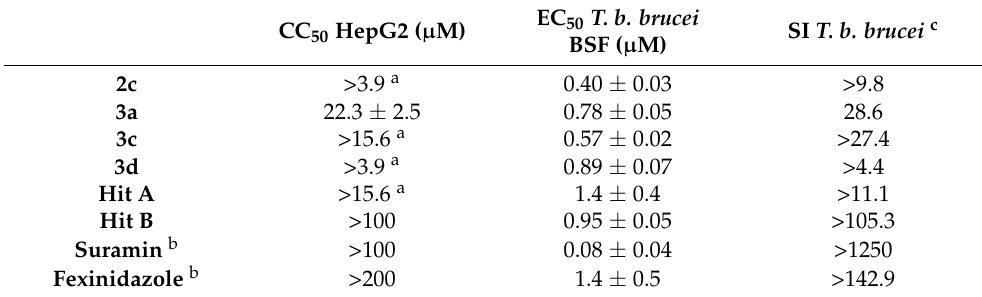
Table 3. In vitro evaluation of molecules 2c , 3a , 3c and 3d on T. b. brucei trypomastigotes